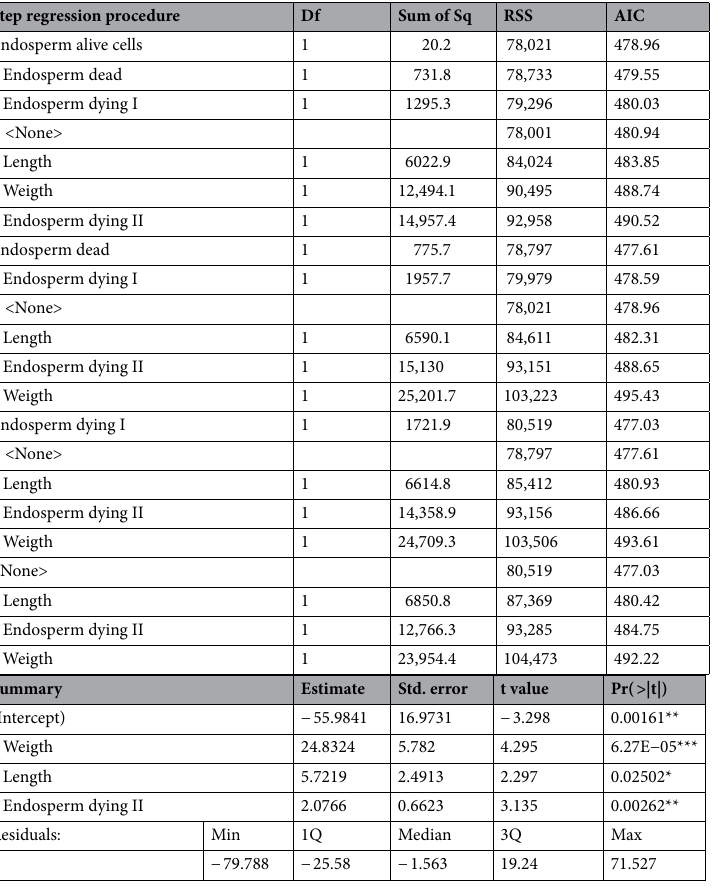
Table 2. Variables significantly dependent on the share of alive cells in embryo according to the model obtained by multiple stepwise linear regression on the basis of 66 data set, residual standart error: 36.04 on 62 degrees of freedom, F-statistic: 10.92 on 3 and 62 DF, p value: 7.466e-06, significance codes: ‘***’ 0.001 ‘**’ 0.01 ‘*’